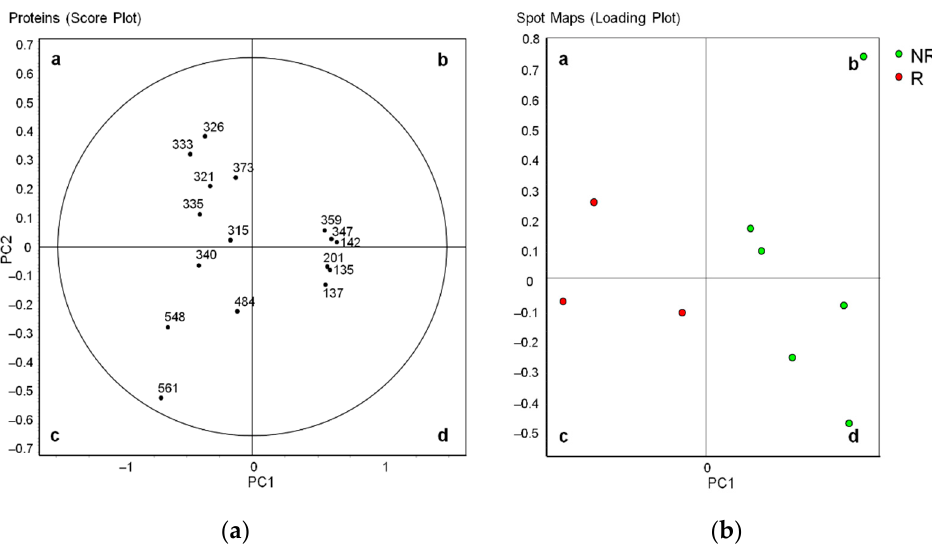
Figure 5. Principal component analysis of 19 differentially abundant spots. ( a ) Score plot, with each circle representing a spot (protein). The 95% significance level is marked by the circle. ( b ) Loading plot, with each circle representing a spot map of a single patient. Green dots, non-relapsed HL; red dots, relapsed HL.